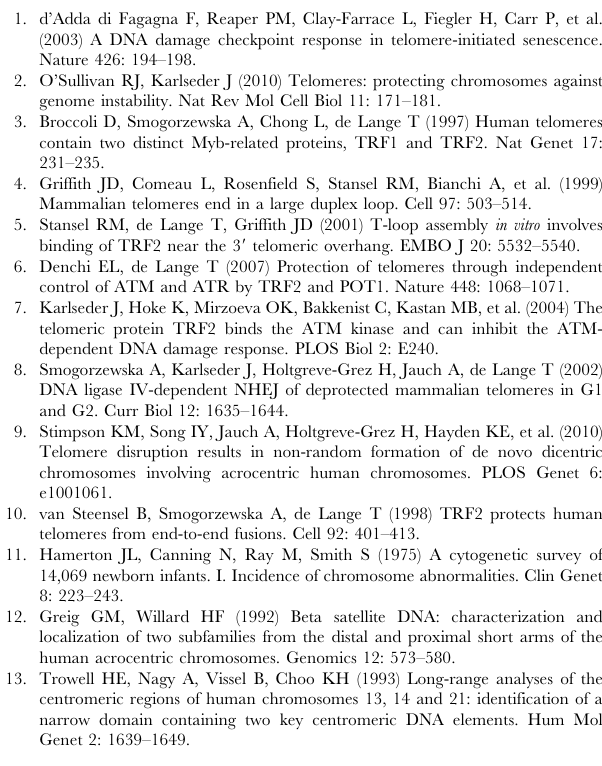
Figure S7 Global rDNA transcription is unchanged during nucleolar disruption. (A) Ongoing transcription in nuclei was visualized by detecting 5FU (green) incorporation into nascent RNA after 30 minutes of 5FU incubation. 5FU signal mainly localized to nucleoli and tracked with the unraveling fibrillarin (red). Uninduced control cells are in the top row, followed by 24-hour, 48-hour, and 72-hour dnTRF2-expressing cells. The bottom two rows show cells treated with Actinomycin D (ActD), an inhibitor of RNA transcription. Scale bars equal 5 micrometers. (B) qRT-PCR analysis was carried out for 45S pre- ribosomal RNA (blue) and 28S ribosomal RNA (green) transcript levels in control, 12-hour, 24-hour, 48-hour, and 72-hour dnTRF2-expressing cells, as well as serum starved (ss), 30 minute ActD, and 3 hour ActD-treated cells. Results are presented as fold change in transcription (based on Ct values) from T19 (uninduced) control cells. (C) 18S RNA FISH signals (green) co-localize with fibrillarin (red) in nuclei from control and T19 cells expressing dnTRF2 for 3 days. Scale bars equal 30 micrometers.